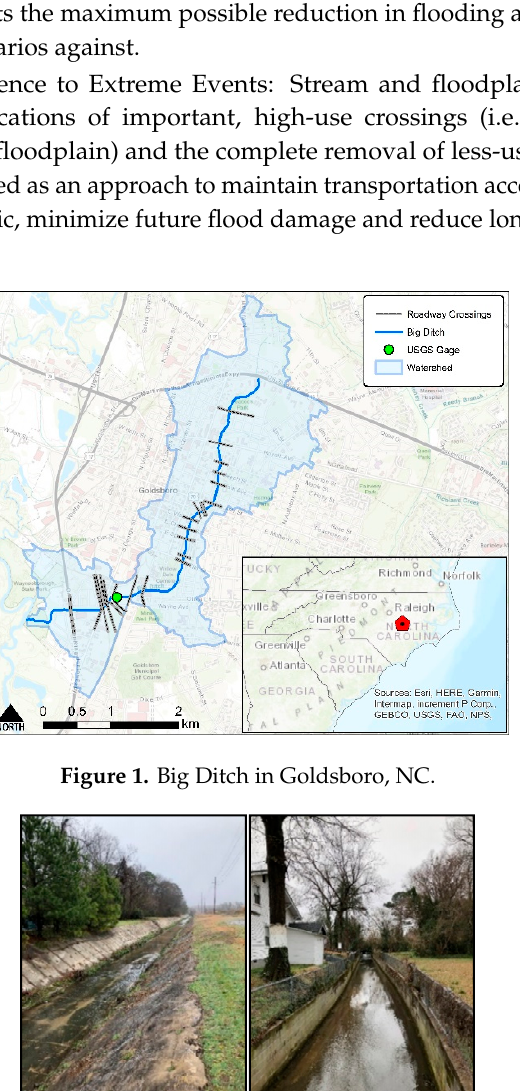
Figure 2. Big Ditch near US 117 ( left ) and at Walnut Street ( right ).